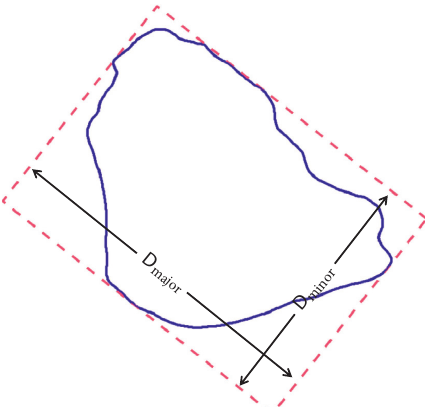
Figure 10: Rectangular box surrounding the particle